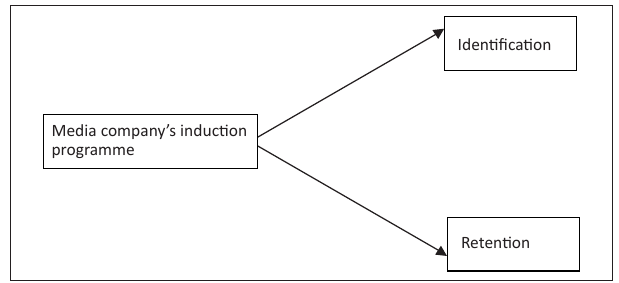
FIGURE 3: Programme theory based on social science